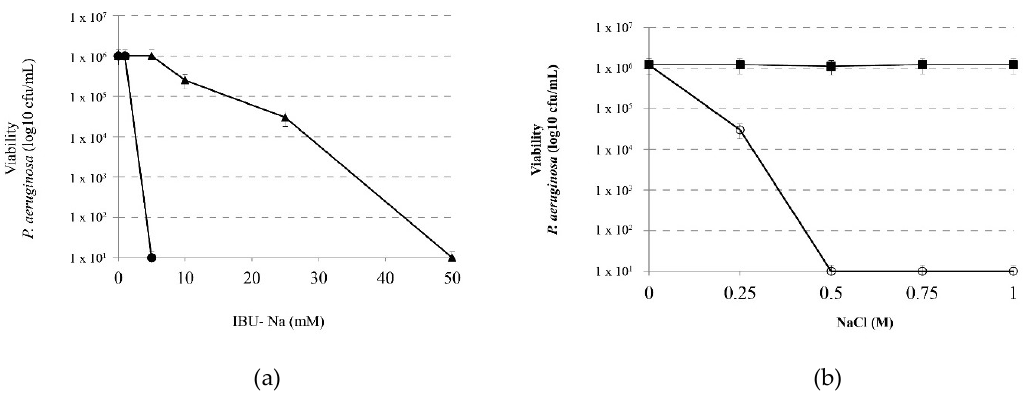
Figure 4. Effect of ionic strength on the bactericidal effect of IBU. ( a ) Viability of P. aeruginosa incubated with IBU-Na (1, 5, 10, 25 and 50 mM) in the absence ( (cid:78) ) and presence ( ) of 1 M NaCl 4 h at 35 ± 2 ◦ C. ( b ) Effect of salt concentration on the bactericidal effect of IBU-Na. Viability of a suspension of P. aeruginosa 1 × 10 6 cfu/mL incubated for 60 min at 35 ± 2 ◦ C with 10 mM IBU ( salt concentration present in the medium. A control of NaCl effect without IBU ( (cid:4) - (cid:4) ) was assayed in similar